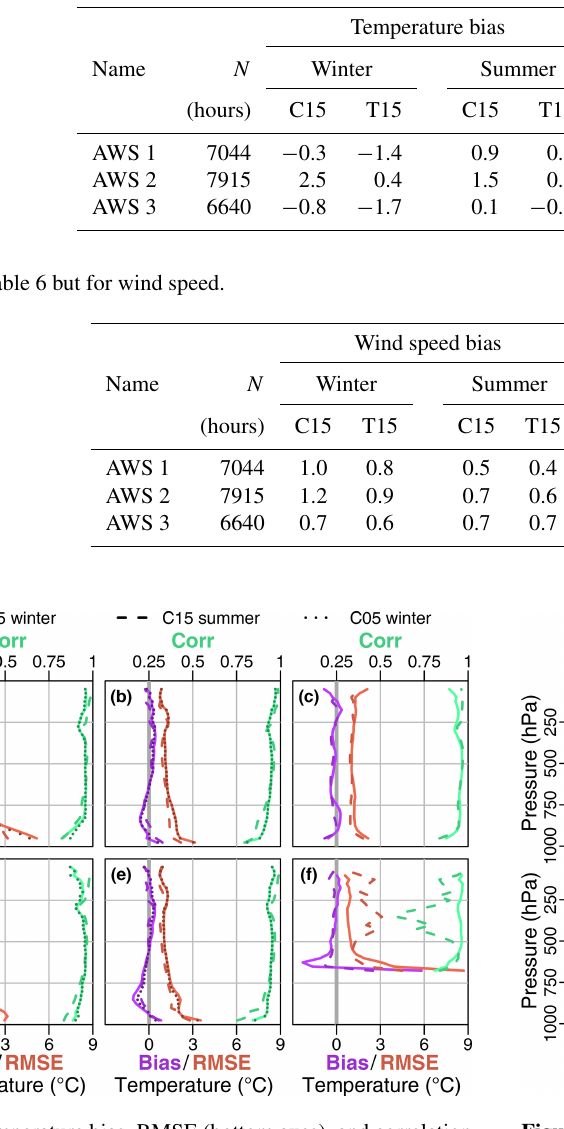
Figure 12. Temperature bias, RMSE (bottom axes), and correlation (top axes) of C15 during winter (solid line), C15 during summer (dashed line) ,and C05 during winter (dotted line) for the stations (a) Marambio, (b) Neumayer, (c) Novolazarevskaya, (d) Rothera, (e) Halley, and (f) Amundsen–Scott.